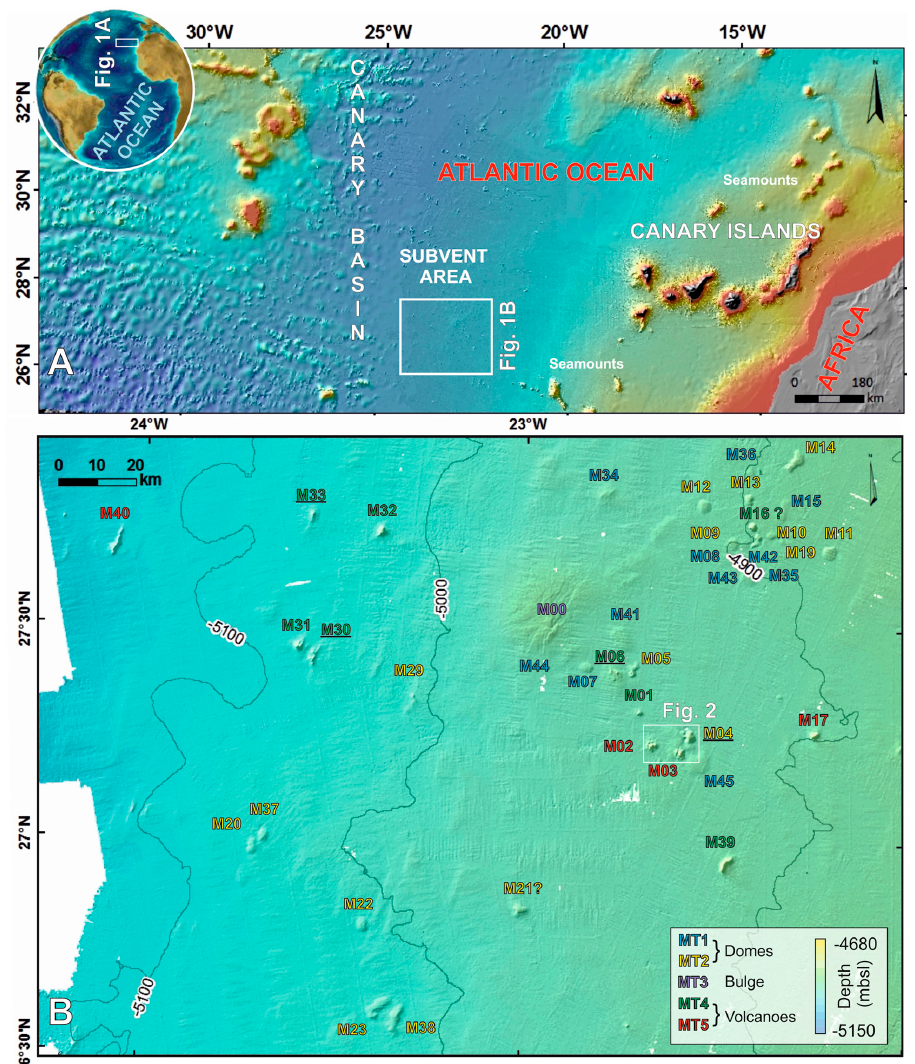
Figure 1. Location of the study area. ( A ) Overview map of the western Canary lower continental slope and location of the study area in the Canary Basin (Central Eastern Atlantic Ocean); ( B ) Subvent Area bathymetric base map where the forty mounds are morphostructurally classified into five types of edifices [42]. The highlighted mounds are categorized according to their origin following [41].